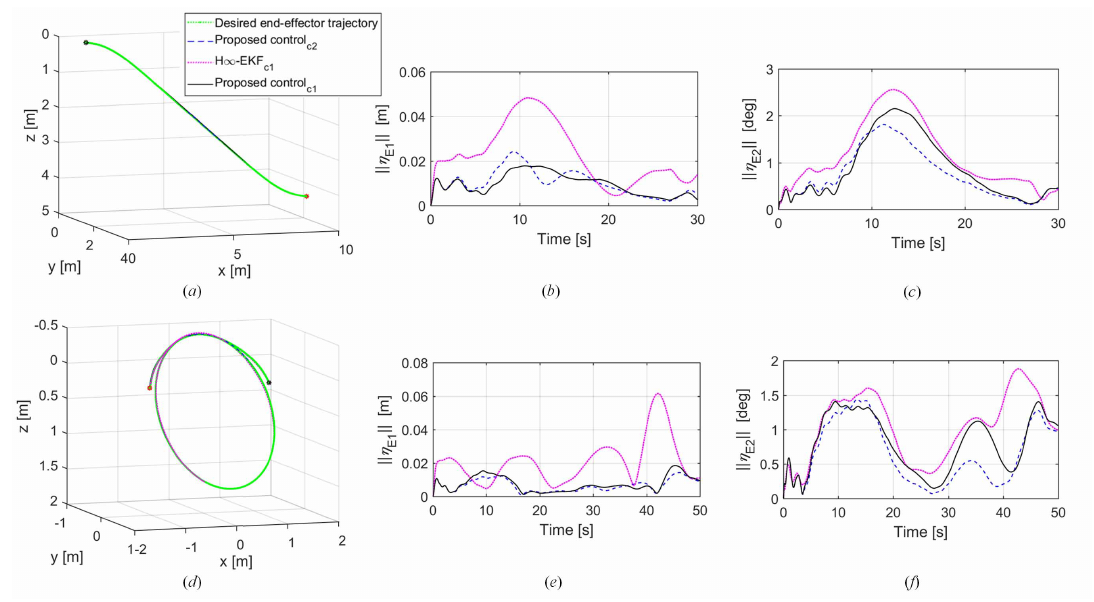
Figure 6. Spatial linear and circular trajectories and their tracking errors. ( a ) Desired linear trajectory and tracking control results; ( b , c ) position tracking errors in positions and orientations; ( d ) desired circular trajectory and tracking control results; ( e , f ) tracking errors in positions and orientations.